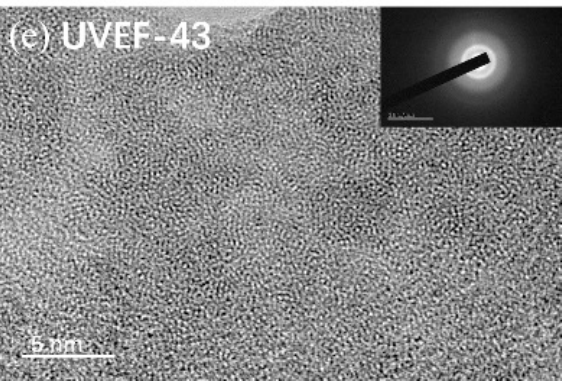
Figure 3. Transmission electron microscopy (TEM)) images of the as ‐ cast sample and the UVEF ‐ samples: ( a ) as-cast; ( b ) UVEF-19; ( c ) UVEF-27; ( d ) UVEF-36; and ( e ) treated samples: ( a ) as ‐ cast; ( b ) UVEF ‐ 19; ( c ) UVEF ‐ 27; ( d ) UVEF ‐ 36; and ( e ) UVEF ‐ 43.